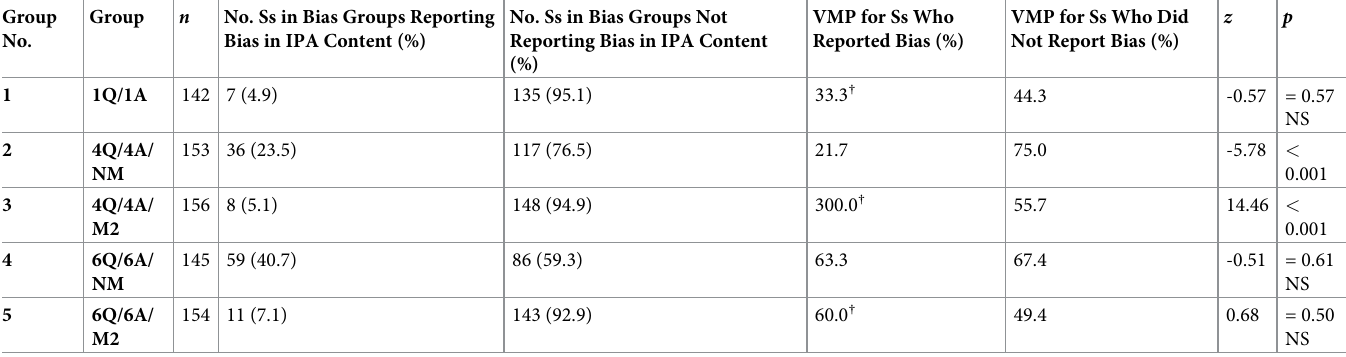
Table 8. Experiment 3: VMPs for people who saw Bias vs. VMPs for people who did not see Bias. Group